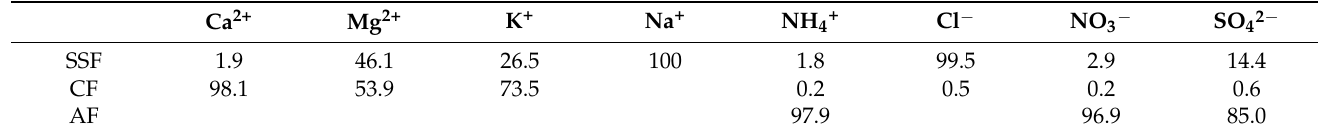
Table 1. Source contributions (%) for major ions in precipitation.